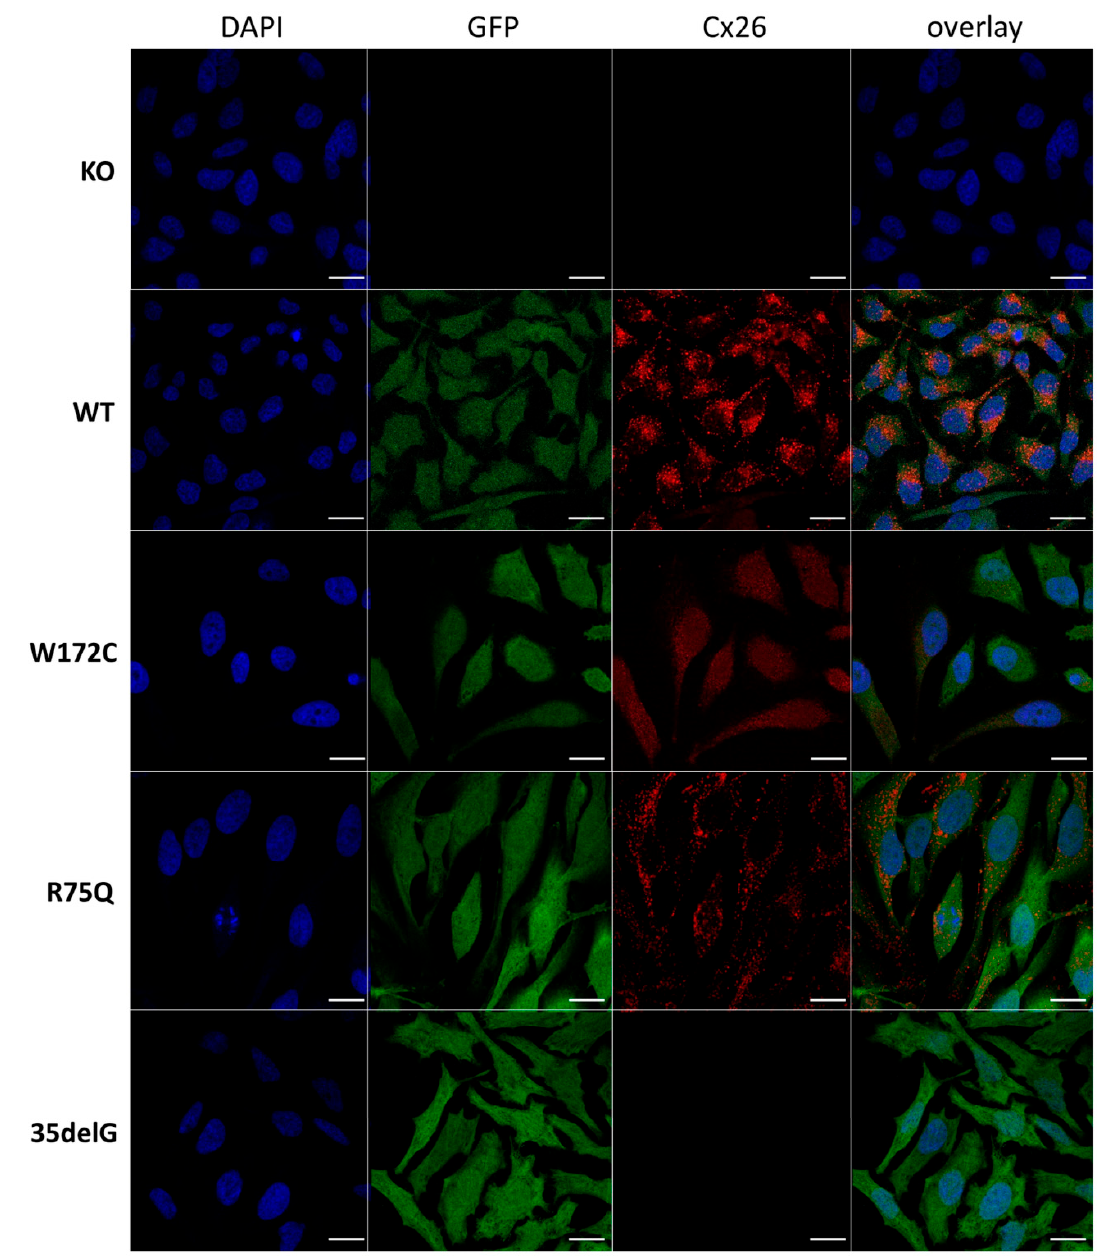
Figure 1. Localization of Cx26 in several newly established HeLa cell lines (confocal micrographs). The panels of Cx26 variants are designated (top down) as KO, WT, W172C, R75Q, and 35delG for cell lines HeLa Cx26-KO, HeLa-Cx26wt, HeLa-p.W172C, HeLa-p.R75Q, and HeLa-c.35delG, respectively. Nuclei were visualized with DAPI (blue), transgenic HeLa cells were visualized with Green Fluorescent Protein (GFP) and Cx26 was immunostained with antibodies against C-terminus of Cx26 (red). Scale bar = 20 µm.